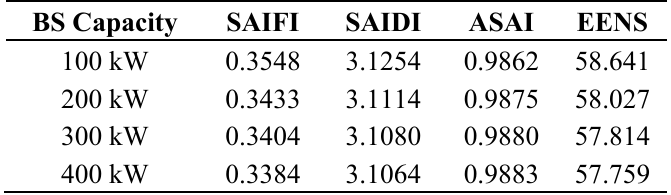
Table 2. System reliability index comparison on different BS